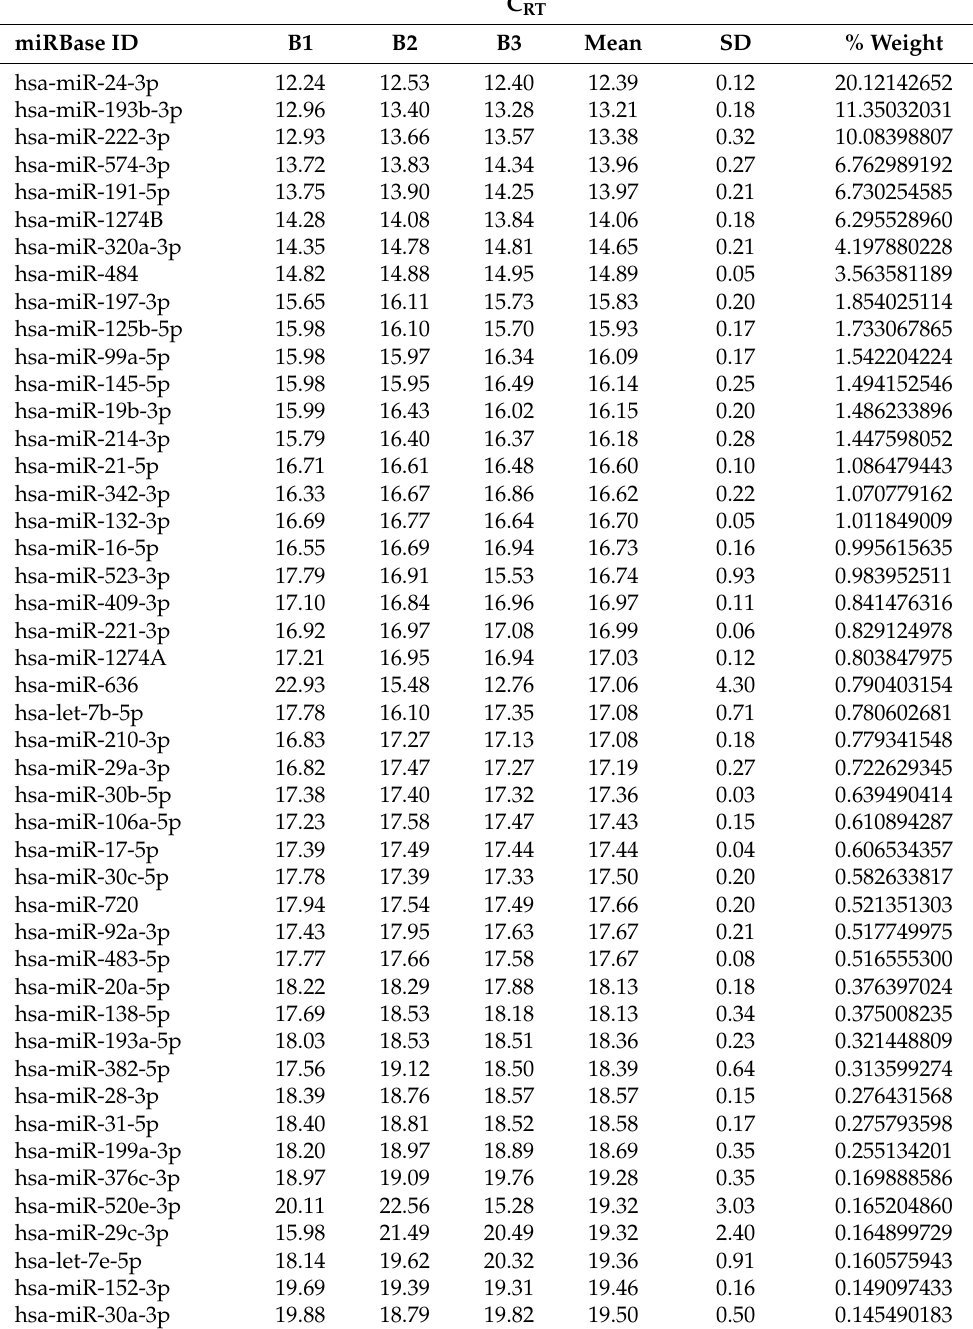
Table 3. EV-miRNAs falling in the first quartile of